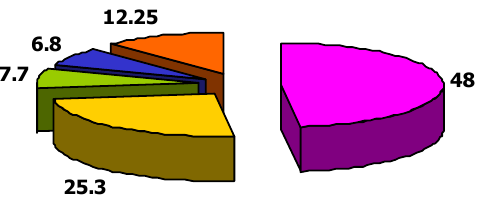
Figure1. Pie chart with breakup of consumable costs